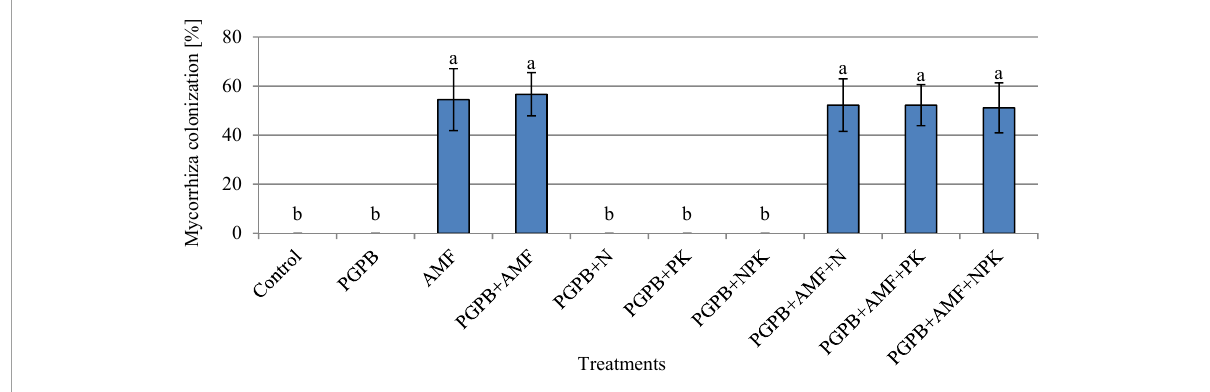
FIGURE3 Mycorrhiza colonization of soybean roots affected by inoculation of plant growth-promoting bacteria (PGPB) and arbuscular mycorrhiza fungi (AMF), with or without the addition of nitrogen (N), phosphorus (P), and potassium (K) fertilizers. Data (Mean ± SD) with different letters are significantly different (Tukey’s HSD, p < 0.05).